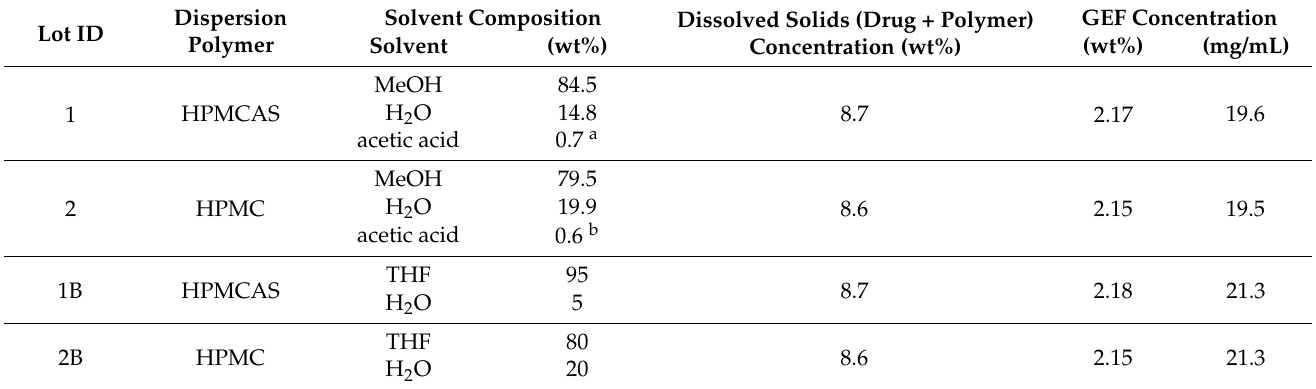
Table 1. Summary of the spray conditions for the 25:75 ( w / w ) GEF:polymer formulations.